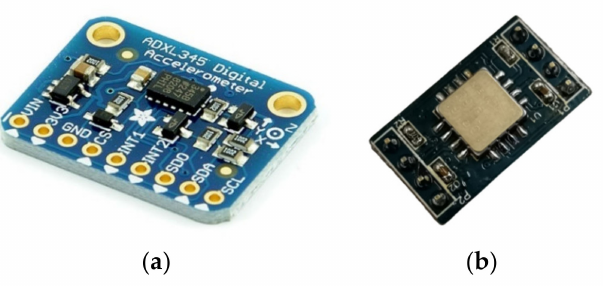
Figure 6. MEMS accelerometers: ( a ) ADXL345 by ANALOG DEVICES; ( b ) MXR9150M by MEMSIC. Table 7. Specifications of accelerometer types—ADXL345 MEMS by ANALOG DEVICES and MXR9150M MEMS by MEMSIC.